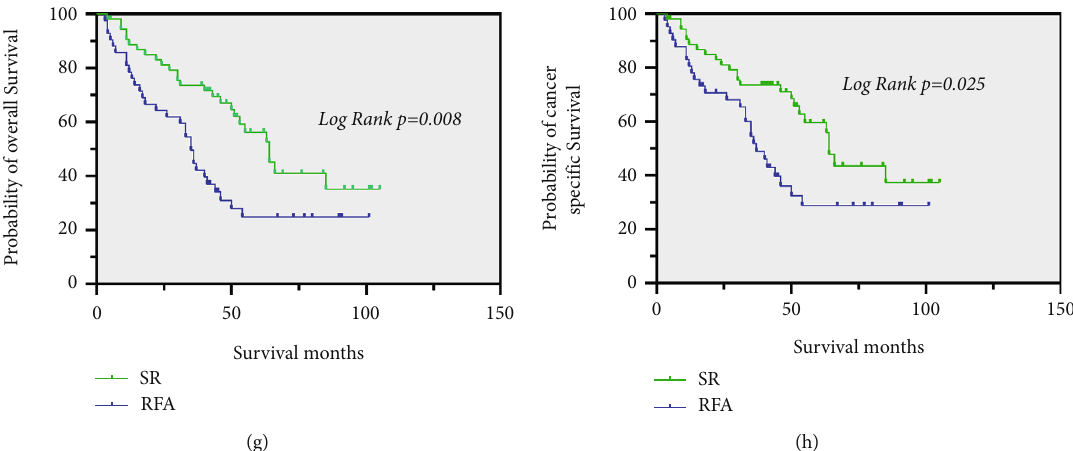
Figure 4: Kaplan – Meier curve of OS and CSS in patients with SR and RFA after PSM — (a and b) patients who received chemotherapy; (c and d) patients with tumor size ≤ 3cm; (e and f) patients with tumor size 3 – 5 cm; (g, h) patients with tumor size > 5